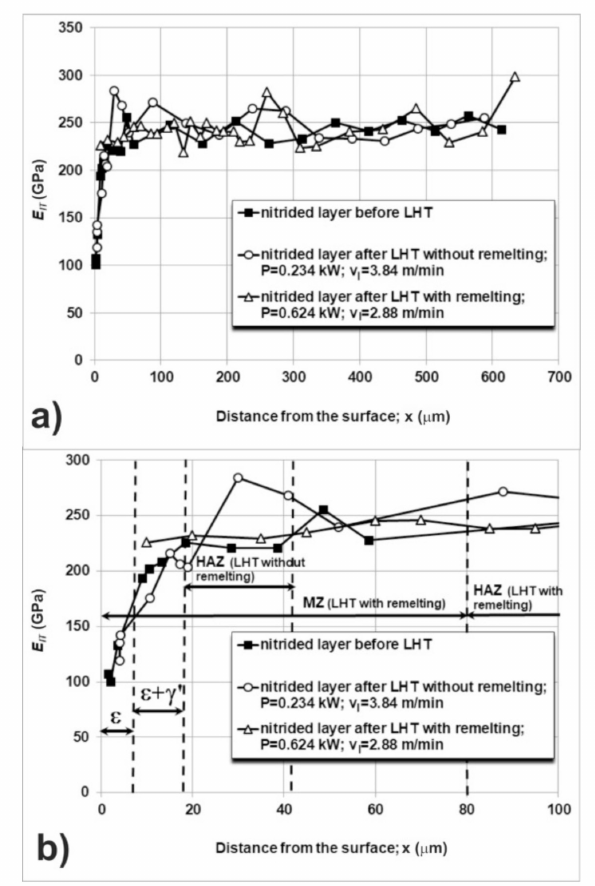
Figure 16. Profiles of indentation modulus E IT in the selected single laser tracks after LHT of gas-nitrided layer with or without remelting compared to the gas-nitrided layer: E IT profiles in the entire layers ( a ); E IT profiles close to the surface ( b